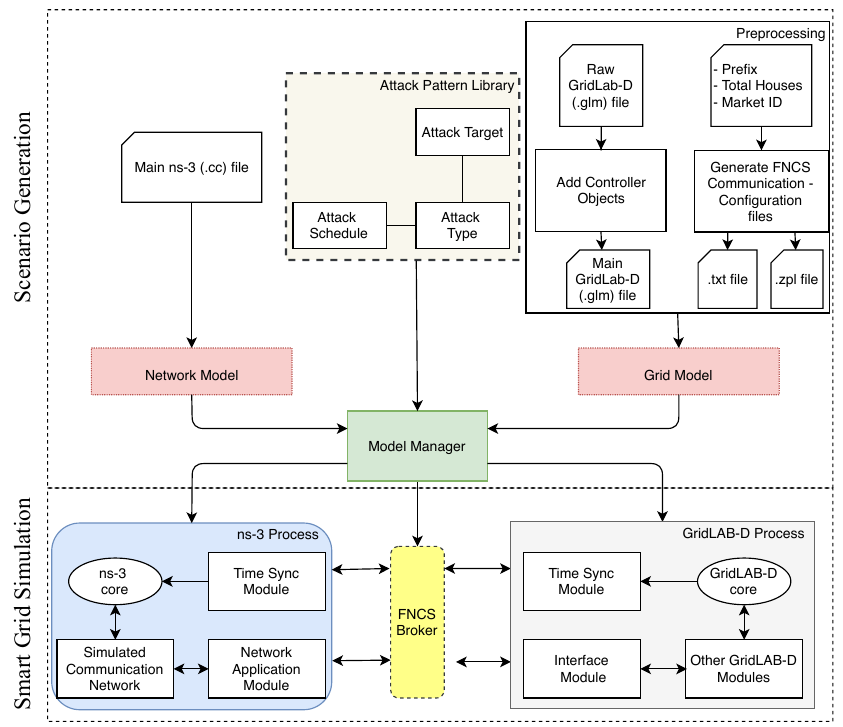
Figure 1. The smart grid attack co-simulation framework—architecture of